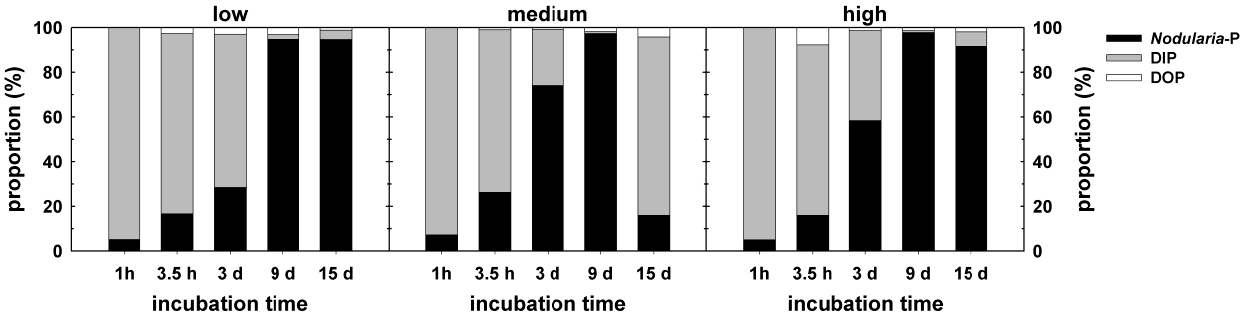
Fig. 5. Proportion of [³³P]PO 4 in the three fractions: Nodularia –P, DIP and DOP over the course of the experiment for the low, medium, and Fig. 5: Proportion of [³³P]PO high p CO 2 course of the experiment for the low, medium, and high p CO